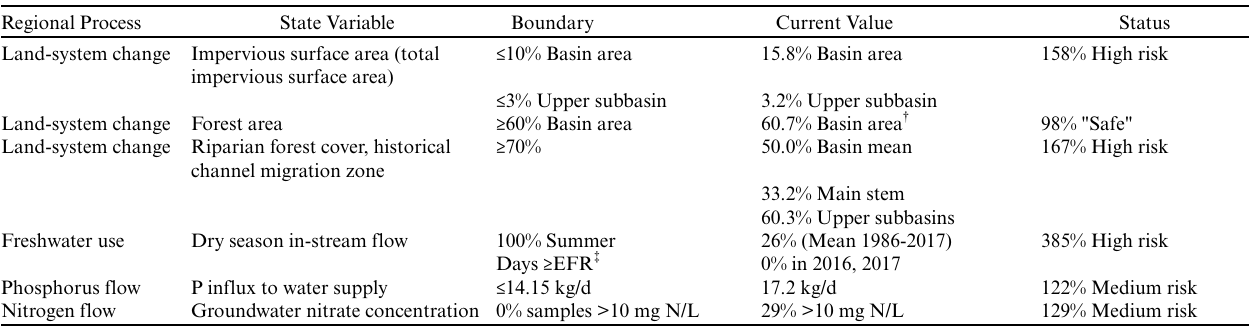
Table 6 . Regional boundaries in driver-pressure-state-impact-response (DPSIR) framework. Regional variables are analogs of planetary boundaries; relevant Earth-system processes are in the left column. Regional boundary variables measure system states, selected using criteria in Table 2. All boundaries have causal links to multiple impacts, with linkages depicted in Figure 1. Values in the far-right column measure regional boundary transgression (%), with boundaries normalized to 100%. Labels in this column denote regional status relative to the boundary: the high-risk zone exceeds a boundary more than 50% (≥150% of boundary value), intermediate risk exceeds the boundary less than 50%, and the safe space lies within the